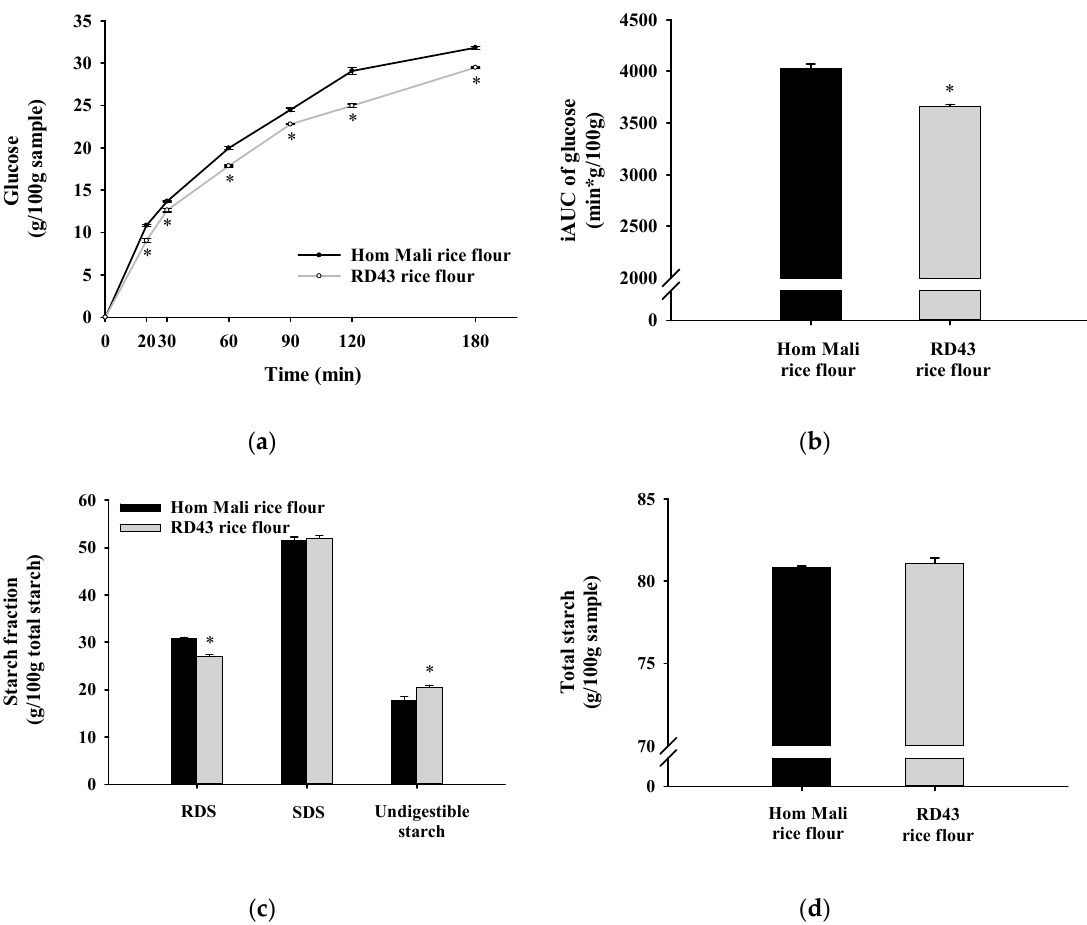
Figure 5. The glucose release during in vitro starch digestion from ( a ) rice flour, ( b ) incremental area under the curve (iAUC) of glucose, ( c ) starch fraction, and ( d ) total starch of Hom Mali and RD43 rice flours. Data are expressed as mean ± standard error of the mean, n = 3. * p < 0.01 compared to Hom Mali rice flour. RDS: rapidly digestible starch, SDS: slowly digestible starch. Table 2. E ff ects of Hom Mali and RD43 rice flour on bile acid binding and the inhibition of cholesterol